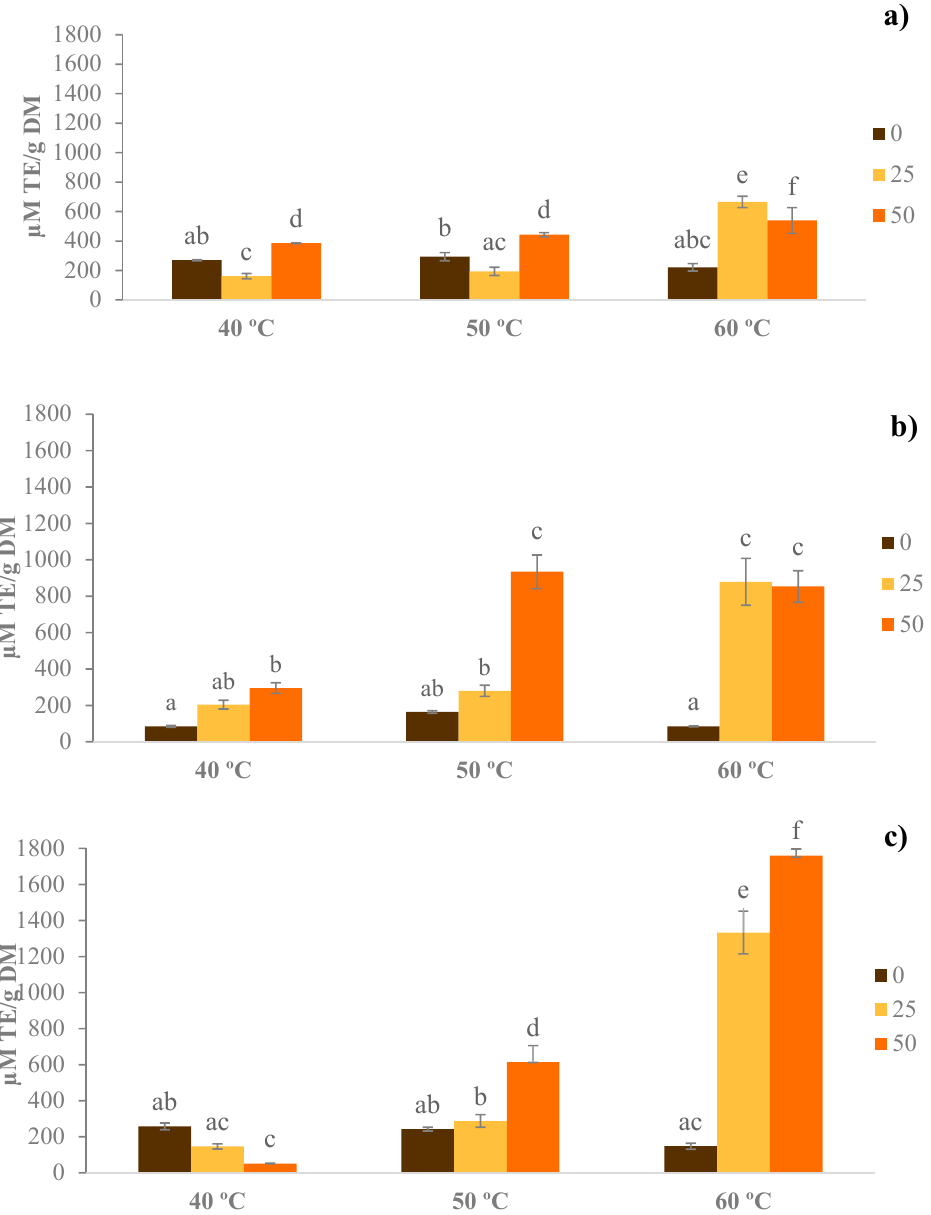
Figure 3. Total antioxidant capacity μ M Trolox equivalents (TE)/g of dry matter (DM), after extraction with different hydroethanolic mixtures (0, 25 and 50% ( v / v ) ethanol:water,), temperature (40, 50 and 60 °C) and extraction time: ( a ) 1 h; ( b ) 2 h; and ( c ) 3 h. Different letters show statistically significant differences ( p < 0.05) for temperatures and concentrations of ethanol used.